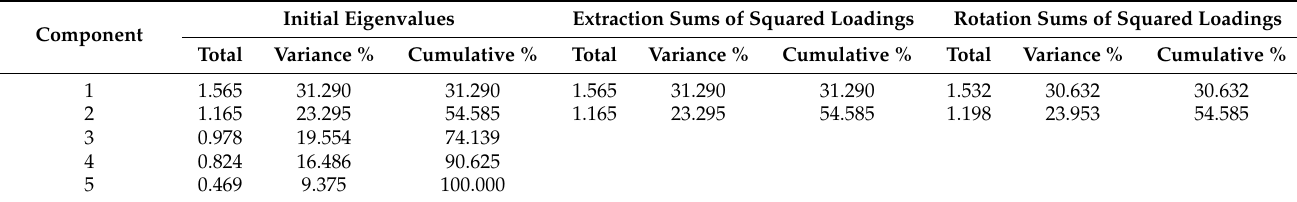
Table 6. Eigenvalues and variance explained with extracted factors of household self-organization and learning (HSoL).